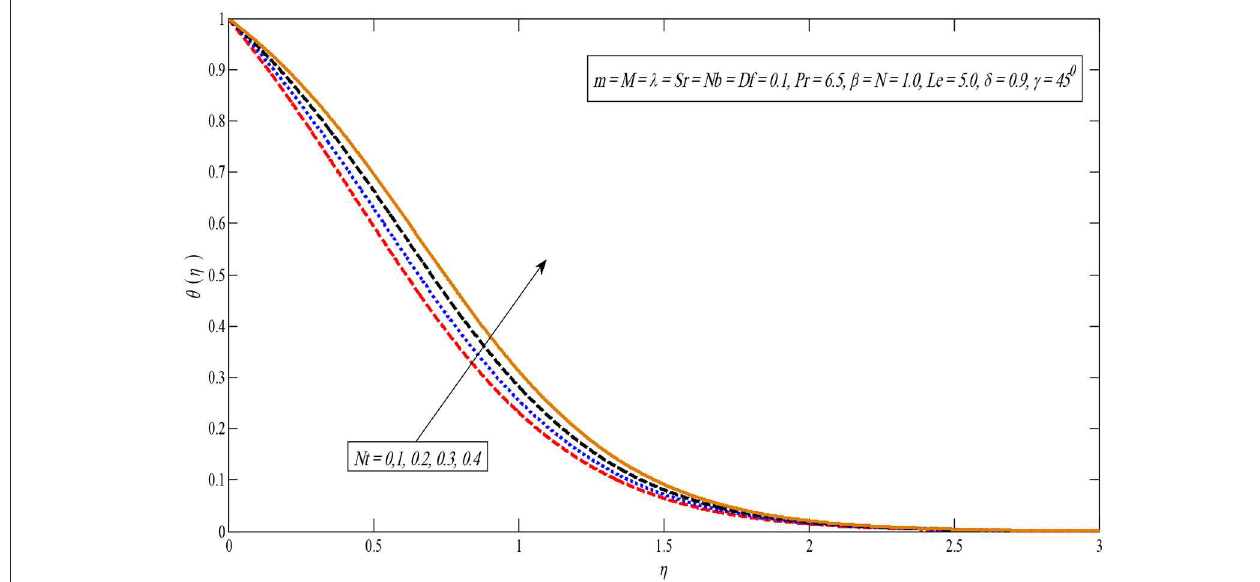
FIGURE 10 | Temperature profile for several values of Nt .